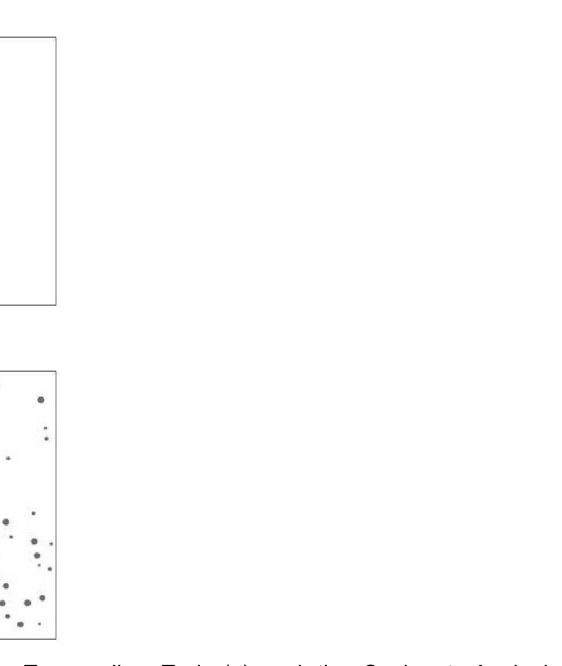
Figure 1. Illustration of the Arabic-to-Analogic Number Transcoding Task (a) and the Spoken-to-Analogic Number Transcoding Task